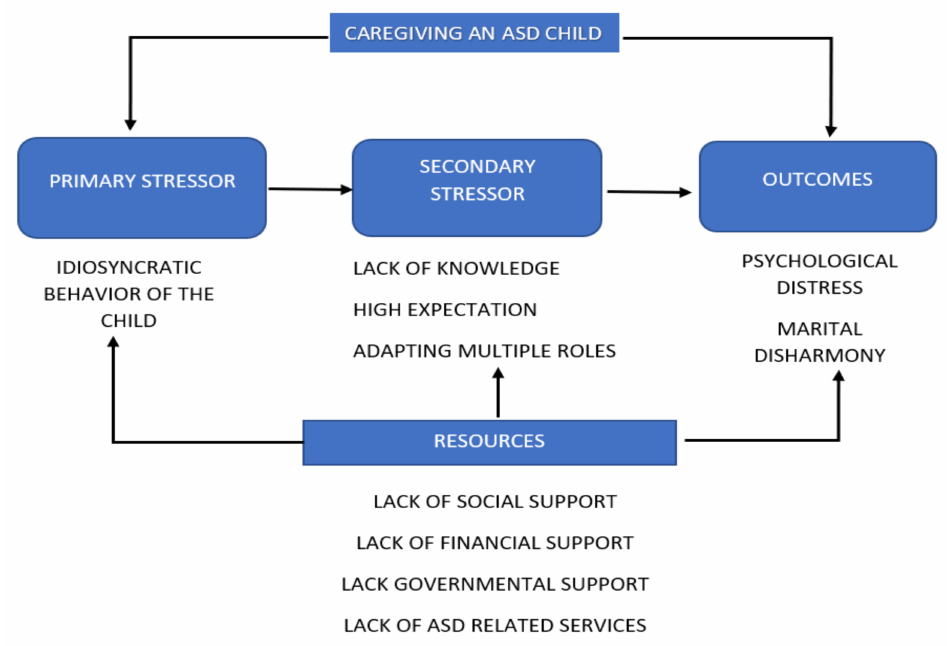
Figure 1. Stressors faced by parents based on the stress process